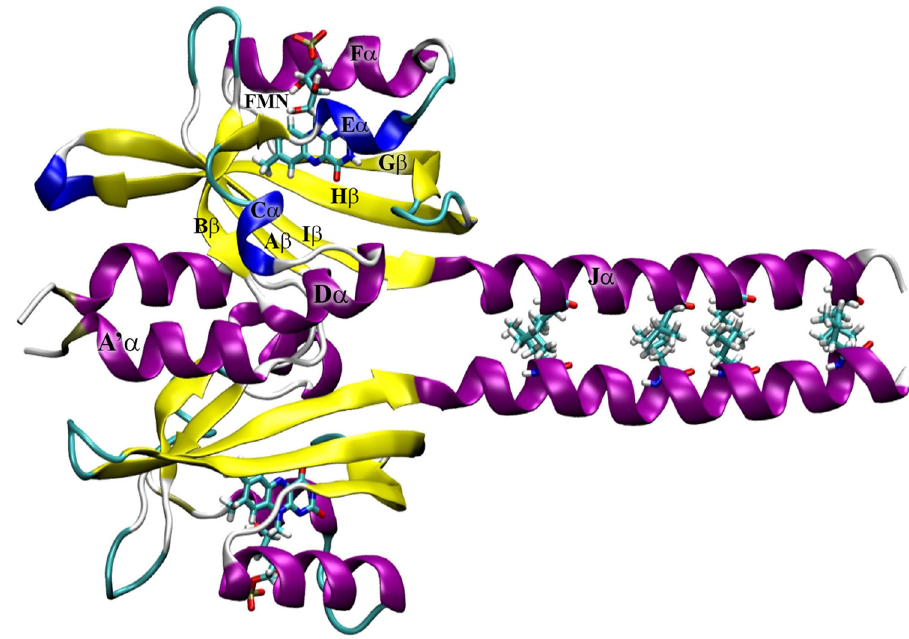
Figure 2: Mr 4511 dimeric model, coloured by secondary structure. The four leucine residues forming the leucine zipper at the long C - terminal helices are highlighted in stick and coloured by atom type. The secondary structure elements are labelled.